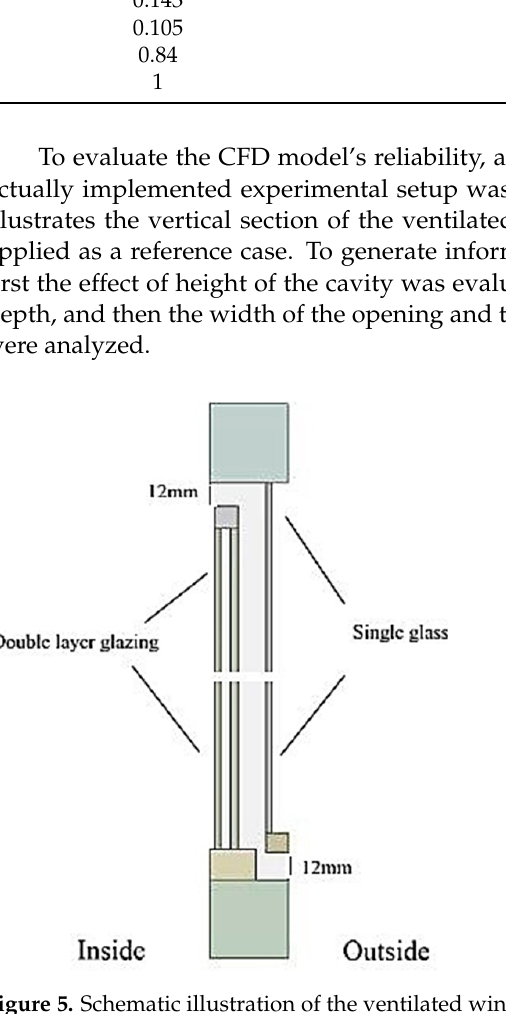
Table 3. Assumed properties of simulated glazing unit.